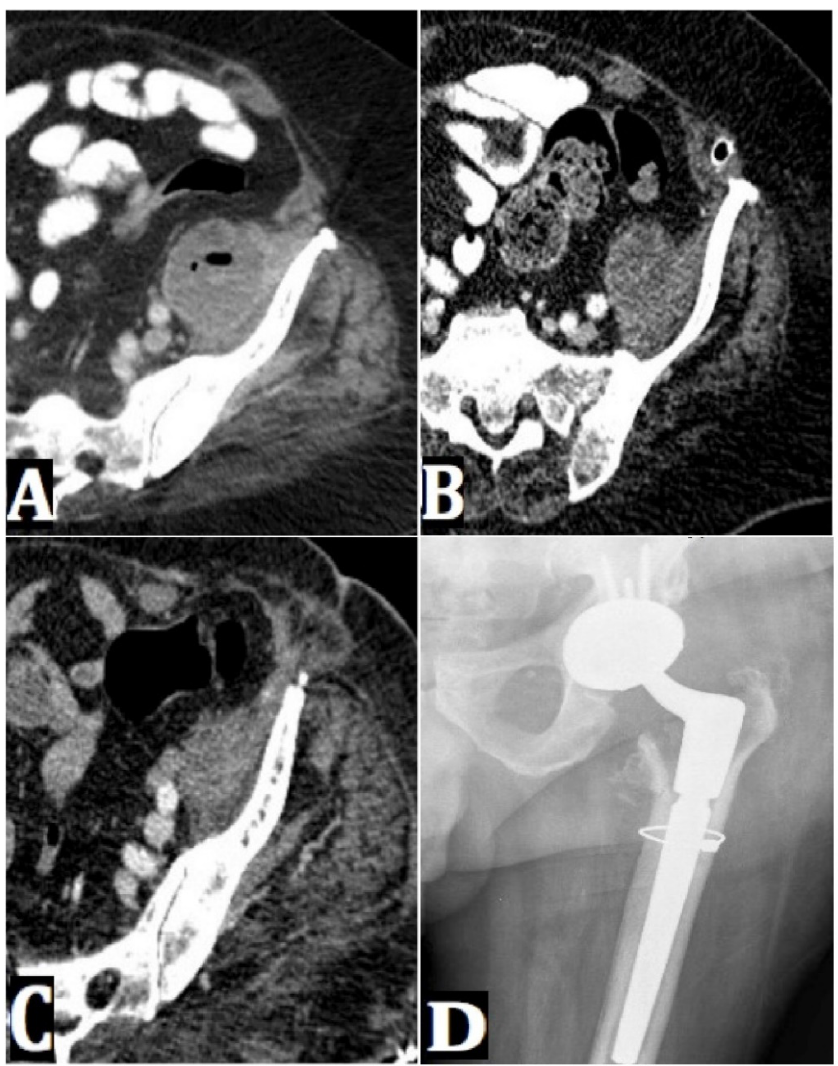
Figure 2. (A) An axial CT pelvis image shows a fluid collection in the left iliacus muscle. (B) A repeat axial CT pelvis image (at six weeks from index imaging) shows no significant change in size of the left iliacus abscess. (C) A repeat axial CT pelvis image (at four months from index imaging) shows a decrease in size of the left iliacus abscess. This occurred following three retroperitoneal debridements, and two spacer exchanges. (D) An AP radiograph of the left hip shows a left hip revision arthroplasty with a cerclage wire in proximal femur and components in expected position. There is no evidence of radiographic loosening at 10 months